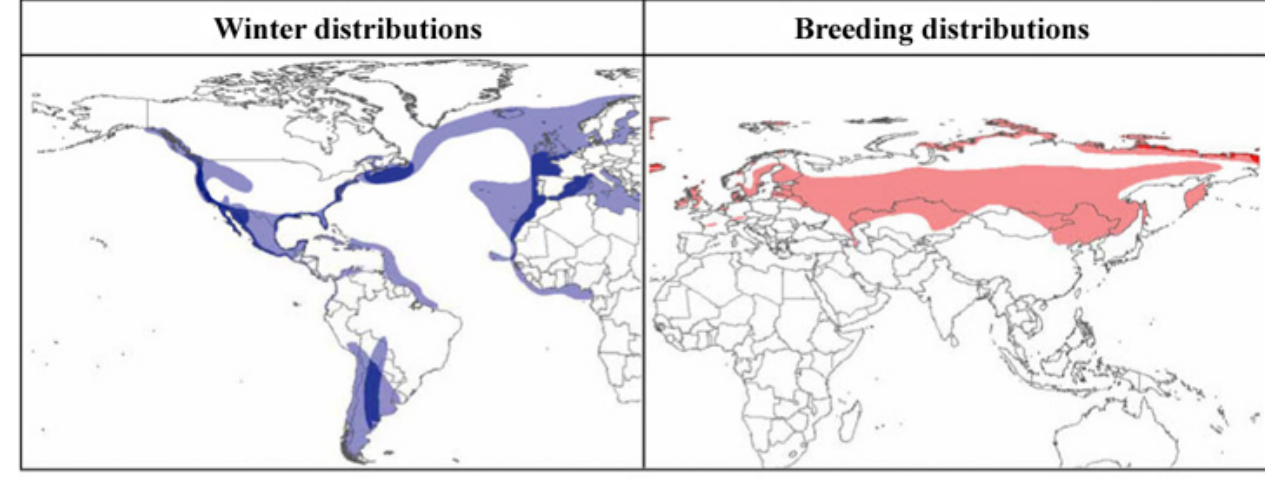
Fig. 4. Summary of wintering and breeding distributions of species that breed across both hemispheres in the Holarctic, but winter at least in part in the Americas; one species ( Larus ridibundus ) ranges considerably farther south in Russia, extending to areas that have indeed seen HP-H5N1 outbreaks. Color ramp indicates numbers of species (white = 0, darkest shade = 5 species). From Peterson et al.